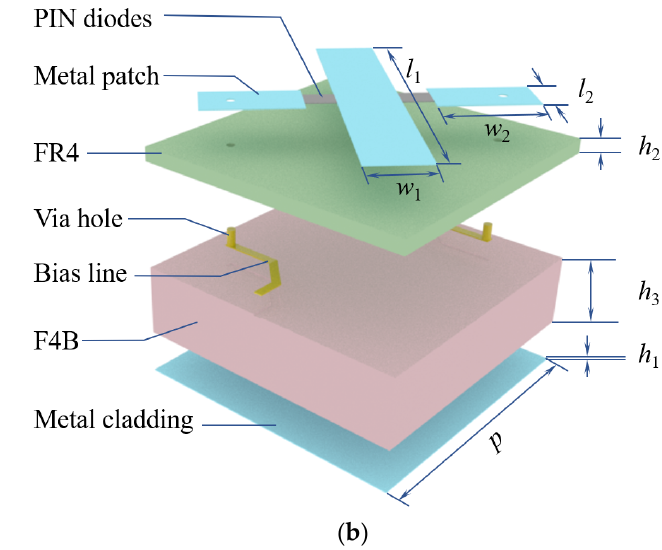
Figure 1. The basic principle of the APCM.